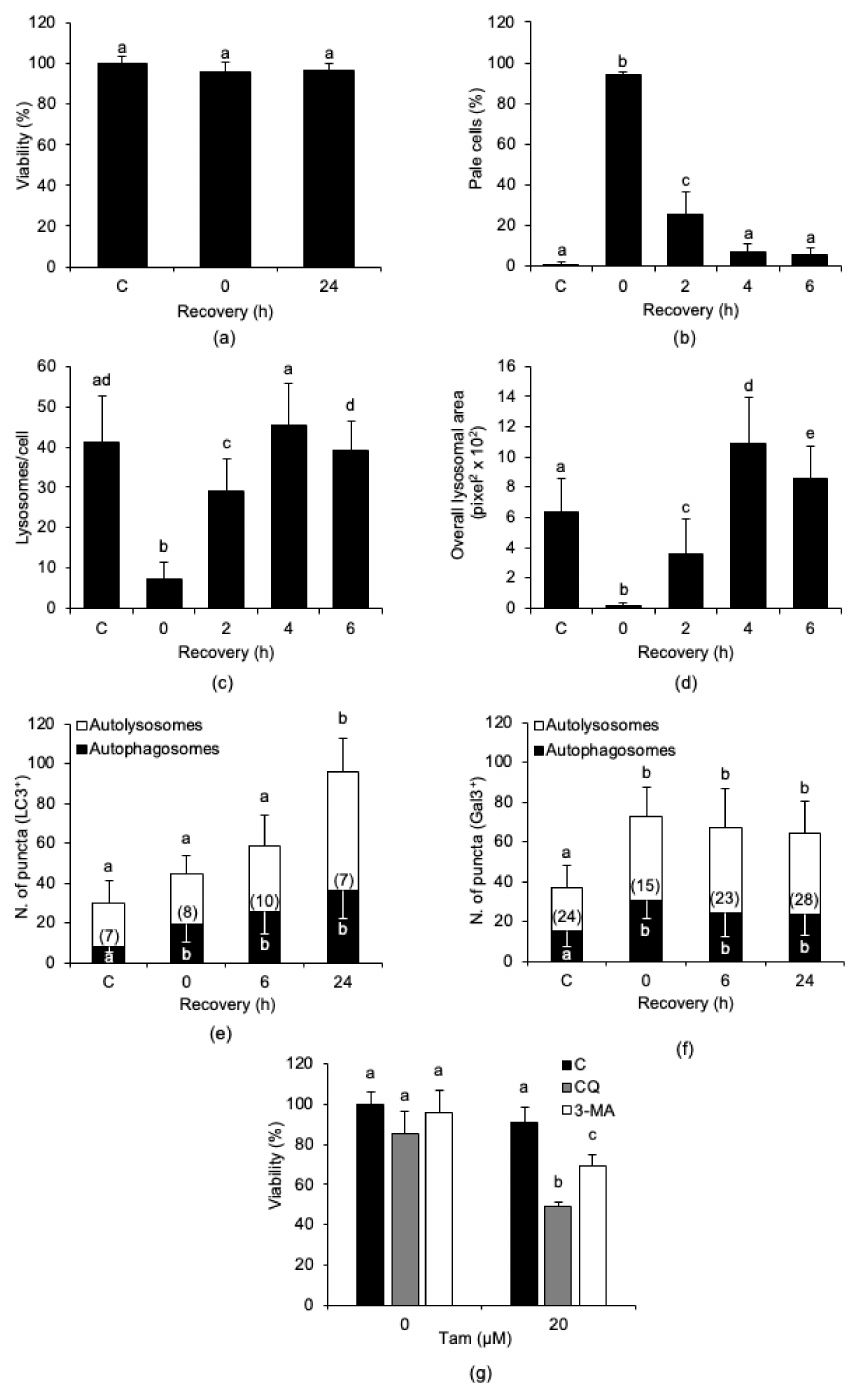
Figure 4. Tam-induced LMP is transient, and its reversion is accompanied by autophagy activation. ( a , b ) Effect of drug removal and of recovery in normal growth medium for up to 24 h on viability ( a ) and LMP induction ( b ) in MCF7 cells treated with 20 µ M Tam for 2 h. Viability and LMP in controls were measured before Tam addition; Tam was removed at time 0. ( c , d ) Effect of Tam removal on lysosome number ( c ) and overall area of lysosomal compartment ( d ). ( e , f ) Activation of autophagy ( e ) and lysophagy ( f ) in MCF7 cells exposed to Tam and allowed to recover as in ( a ). The number of cells analyzed is shown in each bar. ( g ) Effect of autophagy inhibition on viability of MCF7 cells treated as in ( a ) and allowed to recover for 24 h. Data and statistical analysis are as in Figure 1. C: control MCF7